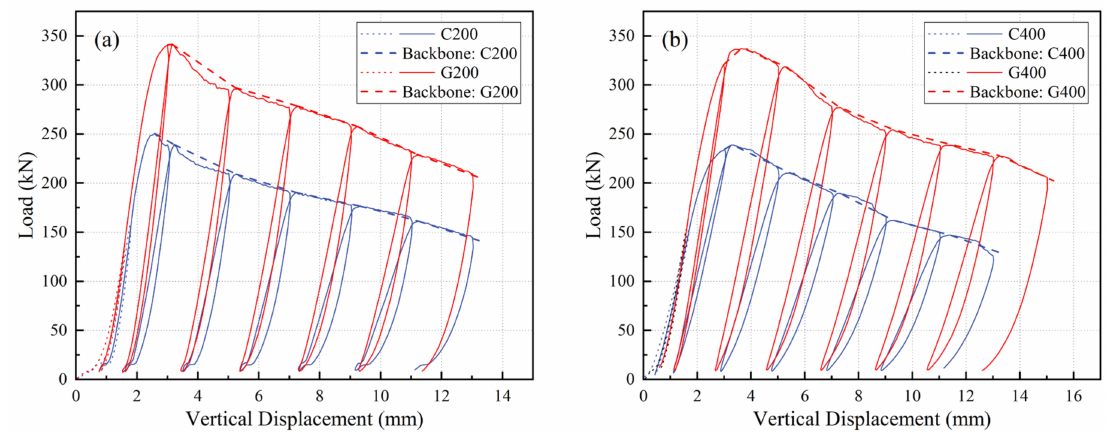
Figure 7. Cyclic responses of unreinforced CLT and GLT columns: ( a ) C200 and G200; ( b ) C400 and G400.